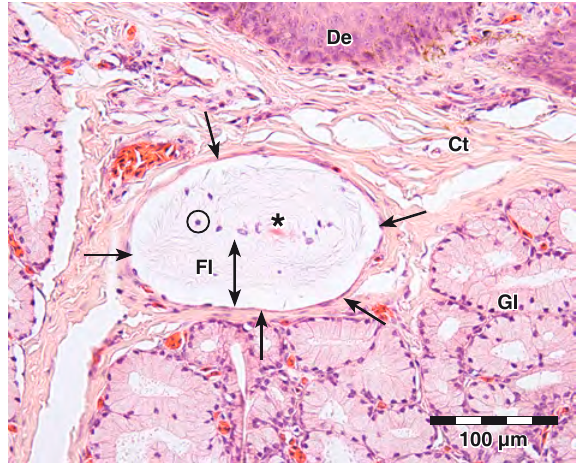
FIG. 8 Dorsum of the tongue showing a Herbst corpuscle (ar­ rows) situated superficially just beneath the dorsal epi­ thelium (De). The corpuscle appears in cross­section and is associated with a large, simple branched tubular gland (Gl). The fibrous capsule (arrows) surrounding the outer core of fibrocytic lamellae (Fl) contains sparse fibrocytic nuclei (encircled). Central axon (*), connec­ tive tissue (Ct)